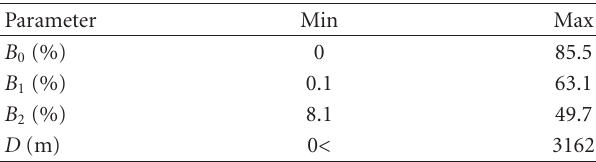
Table 1: Validity intervals of the basic parameters for the obtained model based on the datasets of Bal´azs et al.